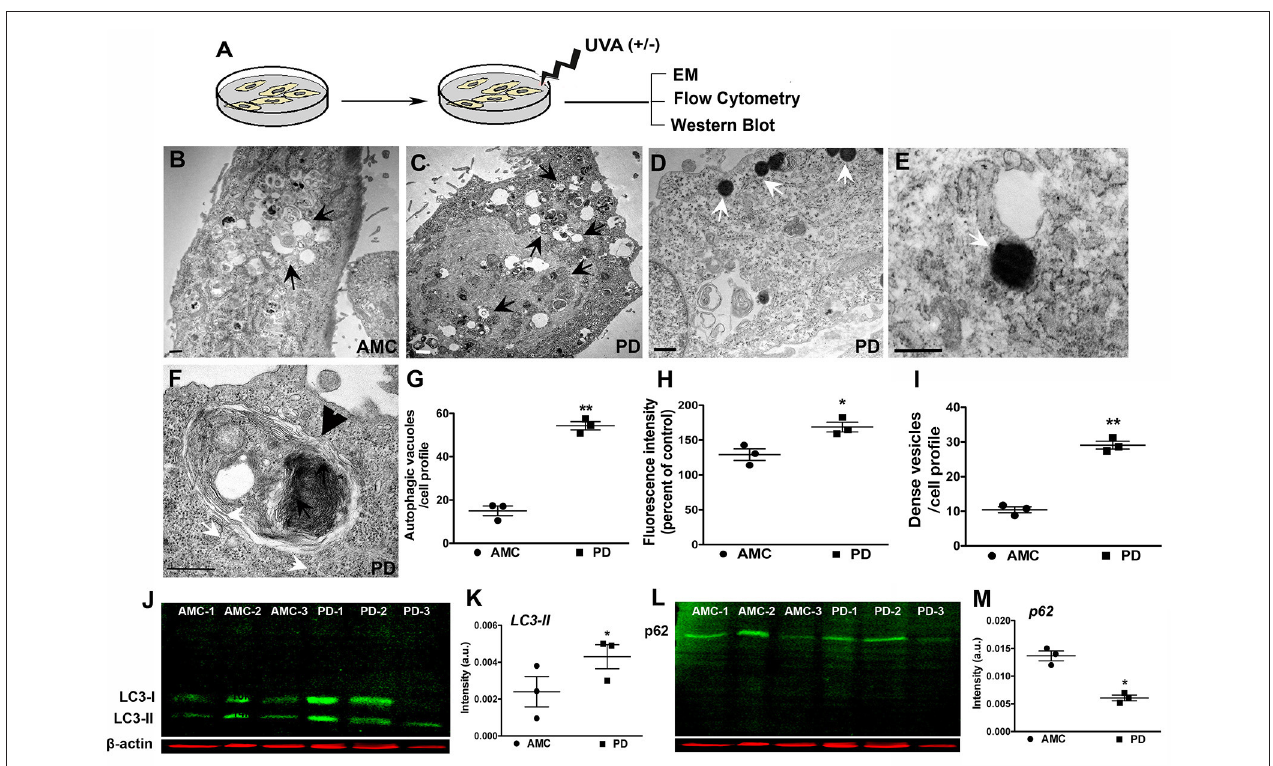
FIGURE 6 | Increased autophagy in PD fibroblasts after UVA stress. (A) Schematic of the experimental design. Electron micrograph of a UVA-treated AMC cell showing accumulation of autophagic vesicles is in ( B , arrows). Widespread accumulation of autophagic vesicles and lipofuscin structures is seen in PD cells ( C , arrows). Lipofuscin-like dense structures are seen in PD cells ( D , white arrows, and high magnification view in E ). These are quantified in (I) . A high magnification image of a typical large autophagolysosome in a PD cell ( F , black arrowhead). EM Quantification is in (G) . Flow cytometric analysis showed higher autofluorescence in PD lines after UVA, corresponding to presence of lipofuscin structures (H) . Western blotting indicated higher LC3-II expression in the PD lines (J,K) , and lower p62 expression, suggesting increased autophagic degradation (L,M) . Scale Bars: (B–F) = 500nm. * p < 0.05, ** p < 0.01, (G) one-way ANOVA with Bonferroni’s post-hoc test, (I) Mean ± SEM, unpaired t- tests with Welch’s correction, n = 3 independent PD and AMC